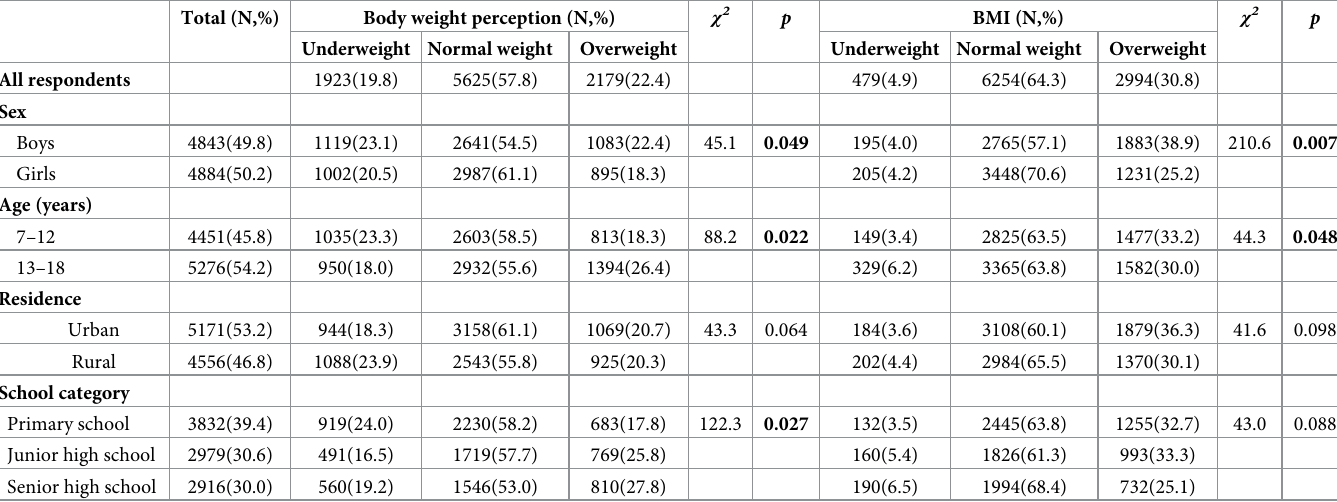
Table 2. Demographic characteristics of the sample in body weight perception and BMI category a .